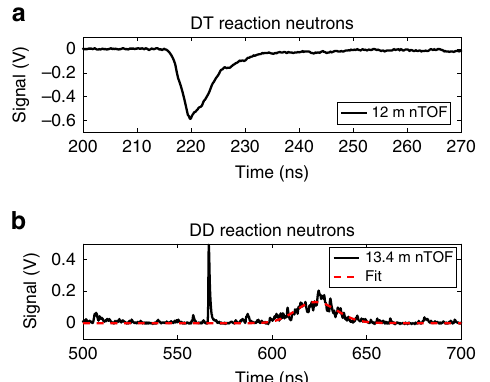
Fig. 6 Neutron time-of- fl ight data frome experiment. The neutron time-of- fl ight signal (red) from shot 80691 is obtained from two separate neutron time-of- fl ight (nTOF) diagnostics positioned 12 and 13.4-m, respectively, from target chamber center (TCC). A forward- fi t approach (dashed-red), shown for the DD reaction, using a relativistic energy distribution is used to analyzed the time-of- fl ight signal to infer the yield and neutron-average ion